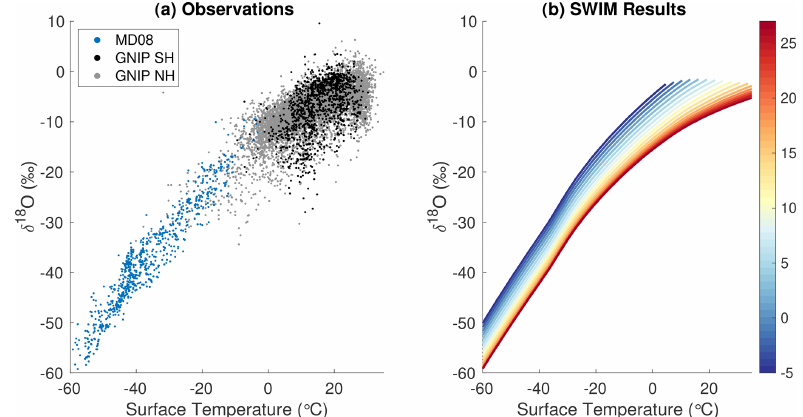
Figure A10. (a) Observed relationship between δ 18 O of precipitation and reported surface temperature in the Masson-Delmotte et al. (2008) database (MD08, blue dots) and the GNIP database from both the Southern Hemisphere (black dots) and Northern Hemisphere (light grey dots). (b) Modeled relationship between δ 18 O of precipitation and surface temperature using our linear scaling, colored by initial evaporation air temperature (in ◦